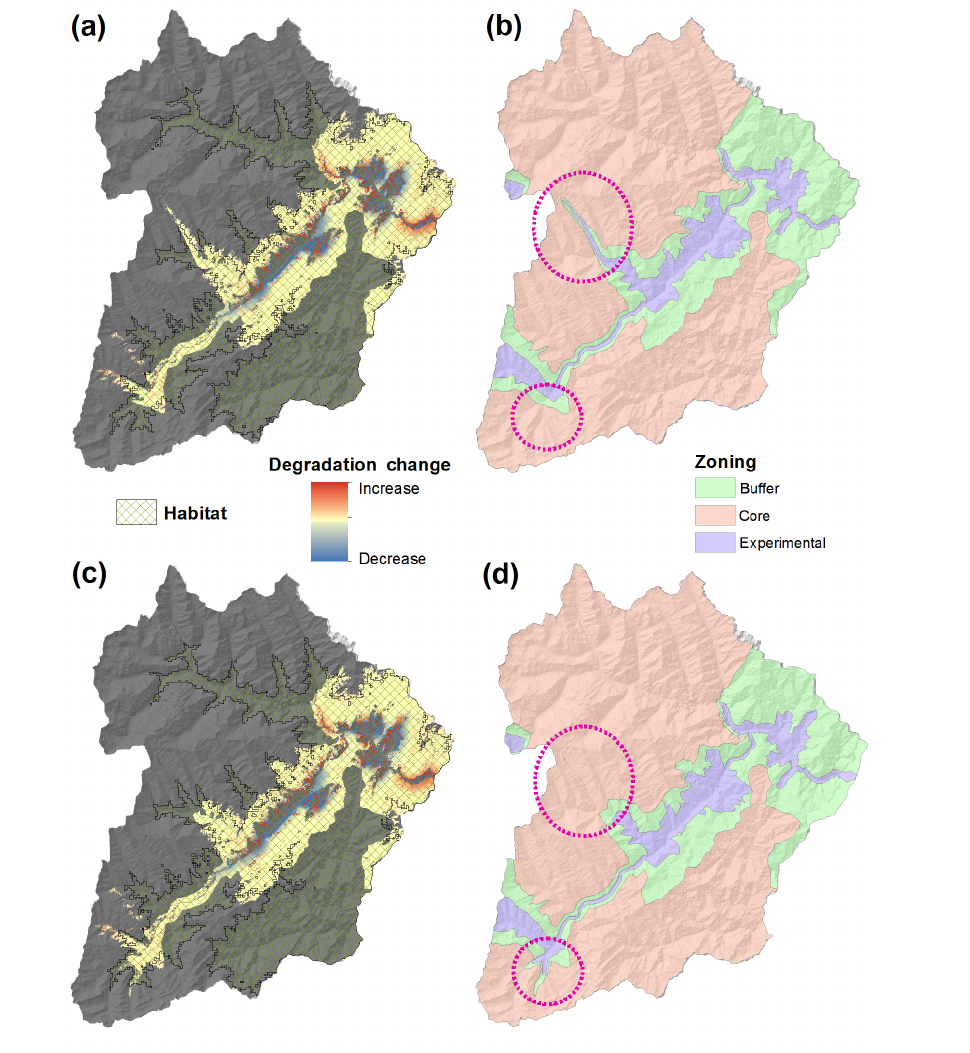
Fig. 11 . Change in habitat degradation for wild pandas between 2001 and 2007 in the Wolong Nature Reserve, China. (a) Increased/decreased degradation under (b) 1998 zoning designation. (c) Potential increased/decreased degradation under (d) scenario of 2009 zoning designation. Habitat degradation is calculated as defined by the Habitat Quality InVEST 3.3.1 model (Sharp et al. 2016). Red indicates an increase (worsening); blue indicates a decrease (improvement). Development is allowed in both experimental and buffer areas, while core areas are protected by law. Areas where zoning designation has changed are